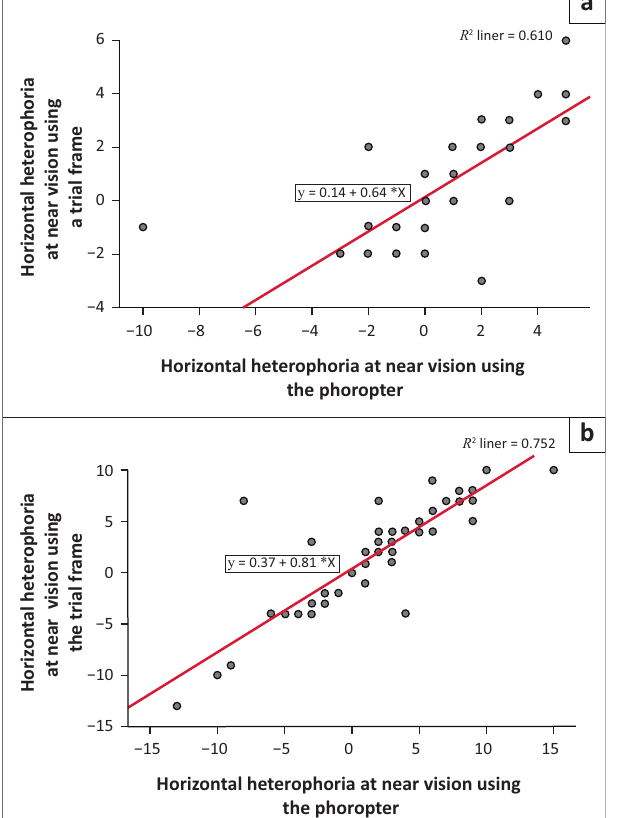
FIGURE 6: Scatter plots of horizontal heterophoria measurements at distance (a) and near vision (b).